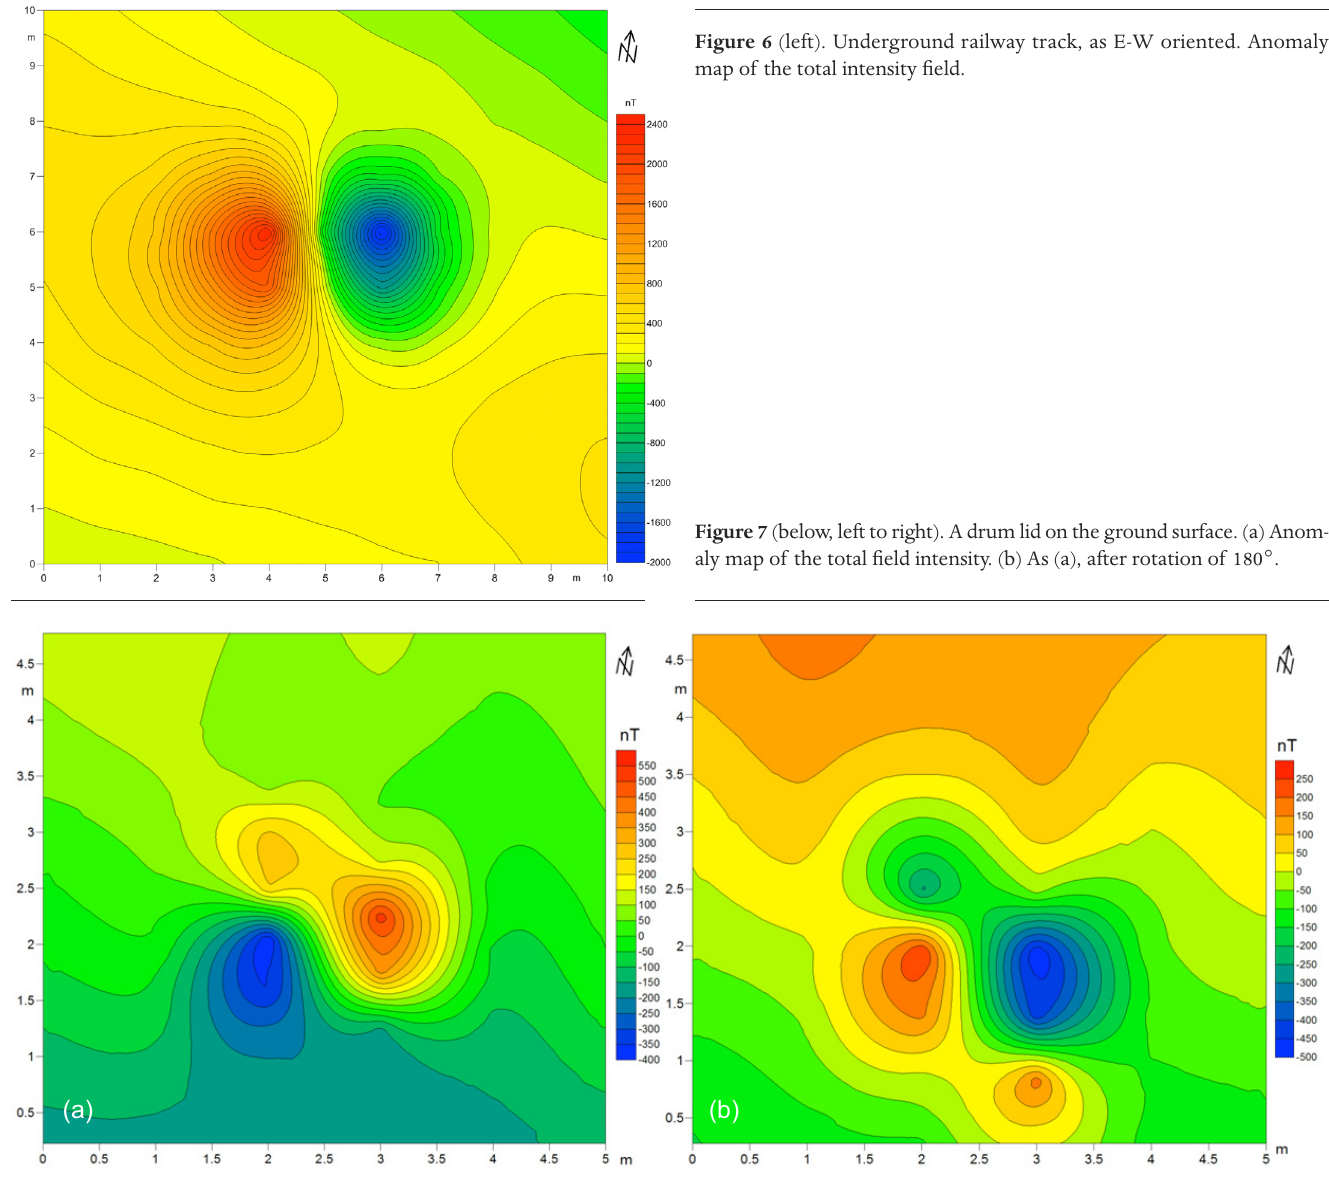
Figure 6 (left). Underground railway track, as E-W oriented. Anomaly map of the total intensity field.